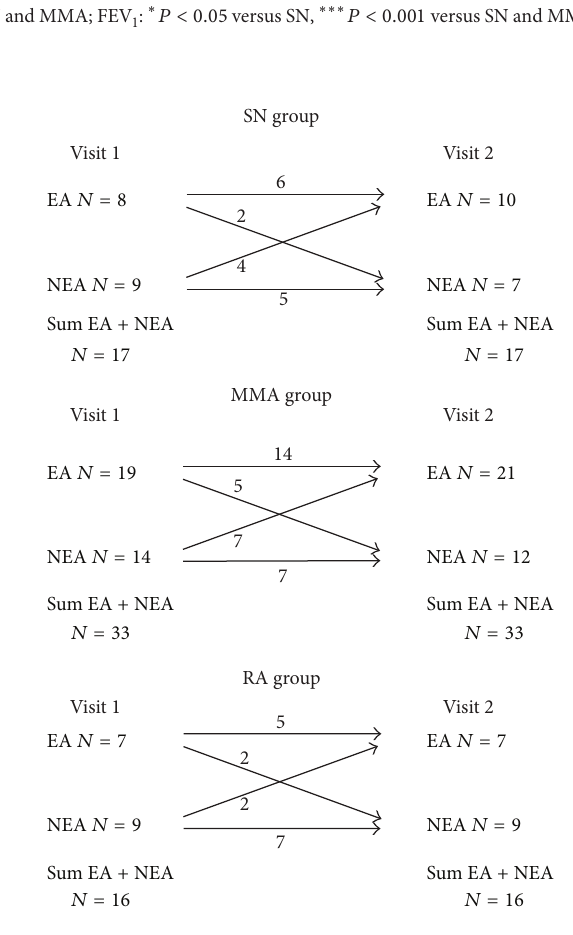
Figure 1: Changes in sputum inflammatory phenotype in studied asthma cohorts: steroid-na¨ıve asthma (SN), mild to moderate asthma (MMA), and refractory asthma